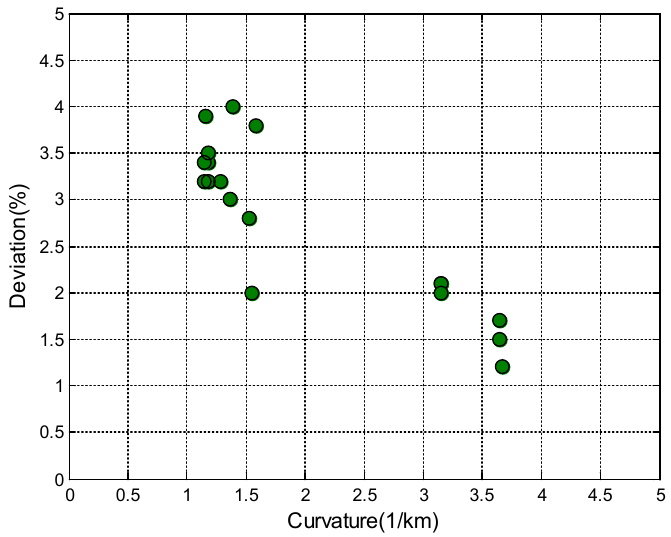
Figure 18. Deviation based on the measured curvature.